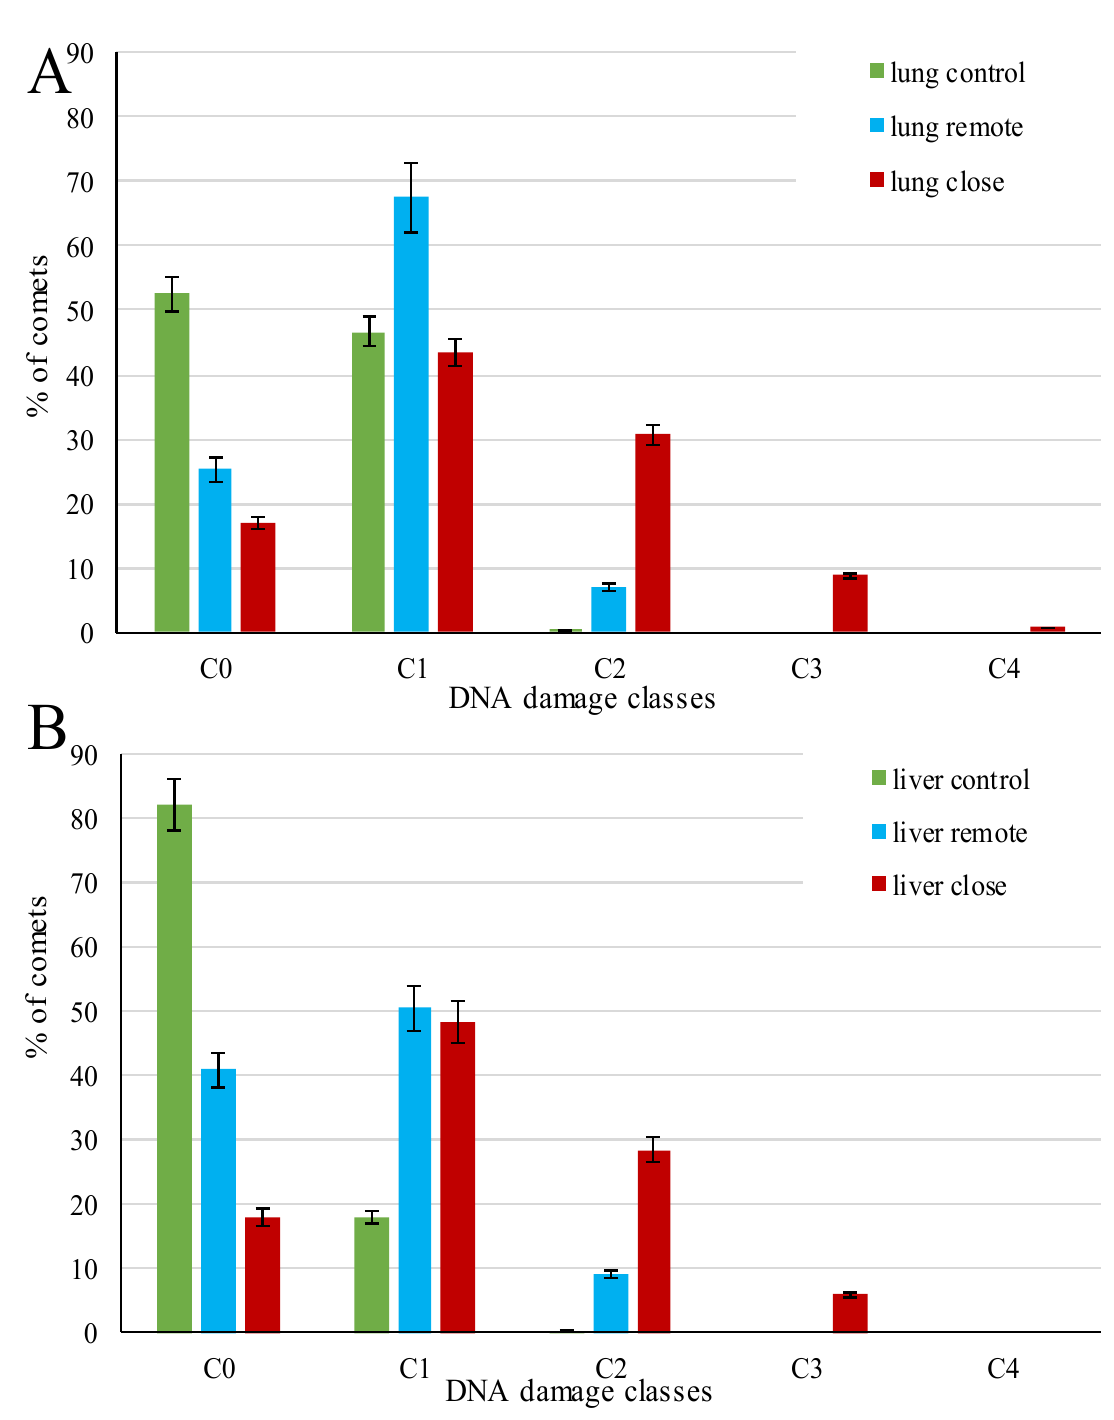
Figure 4. Cell gradation by DNA damage classes in the lung ( A ) and liver ( B ) tissues of control and Paragonimus heterotremus ‐ infected rats. Histograms represent mean value (boxes) and min-max (whiskers). Differences between replicates are statistically nonsignificant ( p = 1.0).